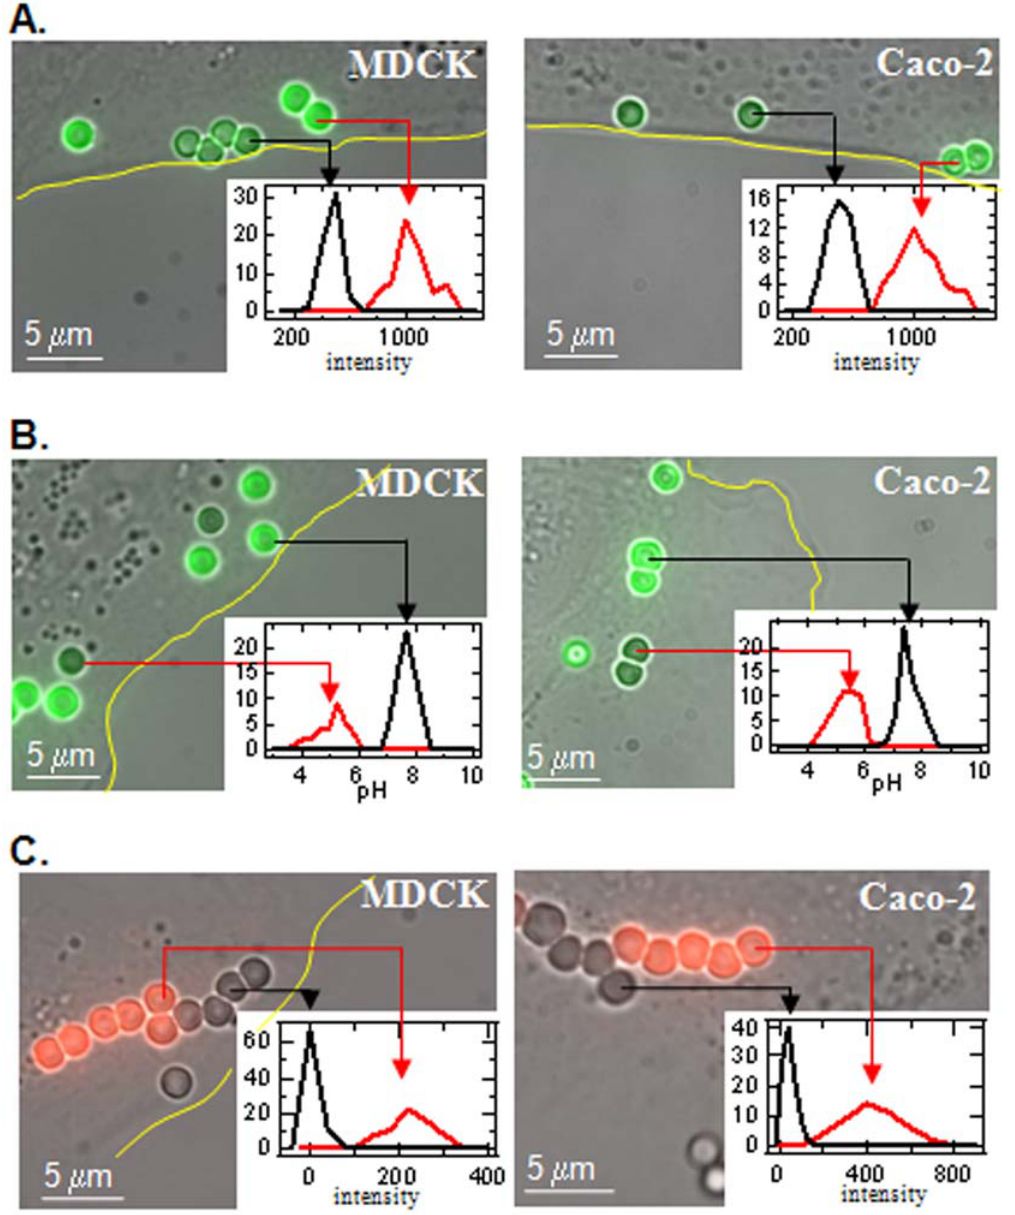
Figure 2. Distinguishing the processes of internalization, phagosomal acidification and phagosomal-endosomal/lysosomal fusion during phagocytosis in epithelial cells via independent, fluorescence-based measurements of Alexa488/InlA-beads, FITC/InlA- beads or unlabeled InlA-beads combined with a red lysosome/endosome dye, respectively. A.) MDCK cells (left panel) and Caco-2 cells after a 20 min or 30 min incubation period, respectively, with Alexa488/InlA-beads. Images were acquired after a subsequent, 30 min incubation period with the anti-Alexa488 quencher antibody. Insets – histogram of the fluorescent intensity of individual Alexa488/InlA-beads (bin width=40 counts). The bimodal distribution results from bead internalization by the cell, where the higher fluorescence intensity peak (red line) represents internalized beads (inside the cell) and the lower intensity peak (black line) represents beads not internalized (outside the cell). B.) MDCK cells (left panel) and Caco-2 cells after a 20 min or 35 min incubation period, respectively, with FITC/InlA-beads. Insets – histogram of the pH of individual FITC/ InlA-beads (bin width=0.25). Bimodal distribution results from internalized beads that exist in acidified phagosomes, where FITC/InlA-beads with lower pH values (red line) indicate beads residing within acidified phagosomes. C.) Lysotracker Red-labeled MDCK cells and Caco-2 cells after a 95 min or 135 min incubation period with unlabeled InlA-beads, respectively. The lysosomes and endosomes of the cells were labeled with Lysotracker Red prior to bead binding. Inset - histogram of the red fluorescent intensity of Lysotracker Red dye co-localized with the unlabeled individual beads (bin width=50 counts). The bimodal distribution results from the co-localization of the red fluorescent Lysotracker dye with the unlabeled beads, which indicates that phagosomal-endosomal/lysosomal fusion has occurred. In all images, the yellow lines denote the edge of the cell and the arrows are included to indicate which fluorescent intensity group (peak) the individual beads correspond to in the bimodal intensity distribution.